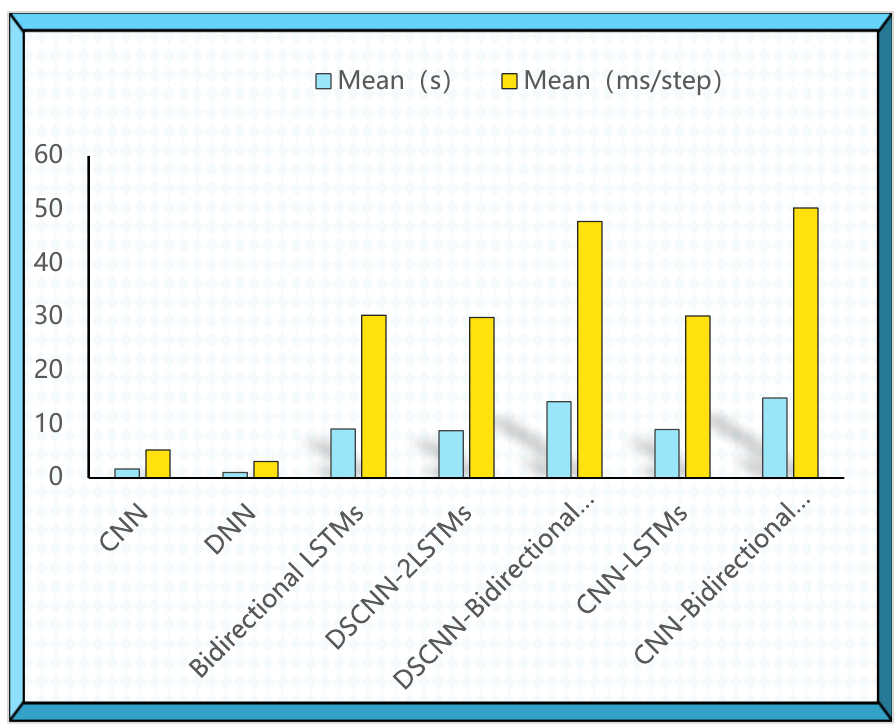
Figure 5. The training time of DSCNN-2LSTM and other models on the binary classification task for each iteration step size. CNN, Convolutional Neural Network; DNN, Deep neural network.